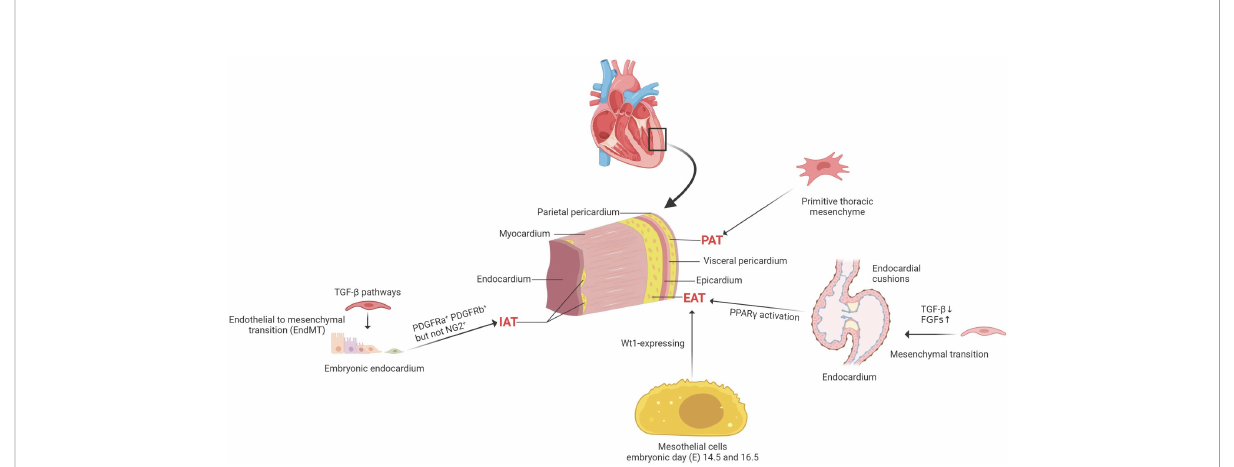
FIGURE 1 The cellular origins of cardiac adipocytes. PAT is situated between the visceral and parietal pericardium, which derived from the primitive thoracic mesenchyme and is vascularized by blood from the thoracic vasculature. EAT is located between the myocardium and the epicardium, mainly deriving from Wt1-expressing mesothelial cells. IAT is observed in the subendocardium in postnatal mouse hearts; both PDGFRa + and PDGFRb + cells, but not NG2 + pericytes, contribute to intramyocardial adipocytes during postnatal heart development and homeostasis. PDGFRa + , platelet-derived Growth Factor Receptors a+; PDGFRb + , platelet-derived growth Factor Receptors b + ; neural-glial antigen 2 + , NG2 + ; PAT, pericardial cardiac adipocytes; EAT, epicardial cardiac adipocytes; IAT, intramyocardial adipose tissues; TGF- b , transforming growth factor- beta; FGFs, fi broblast growth factors; PPAR g , peroxisome proliferator-activated receptor gamma; Wt1, Wilms tumor gene